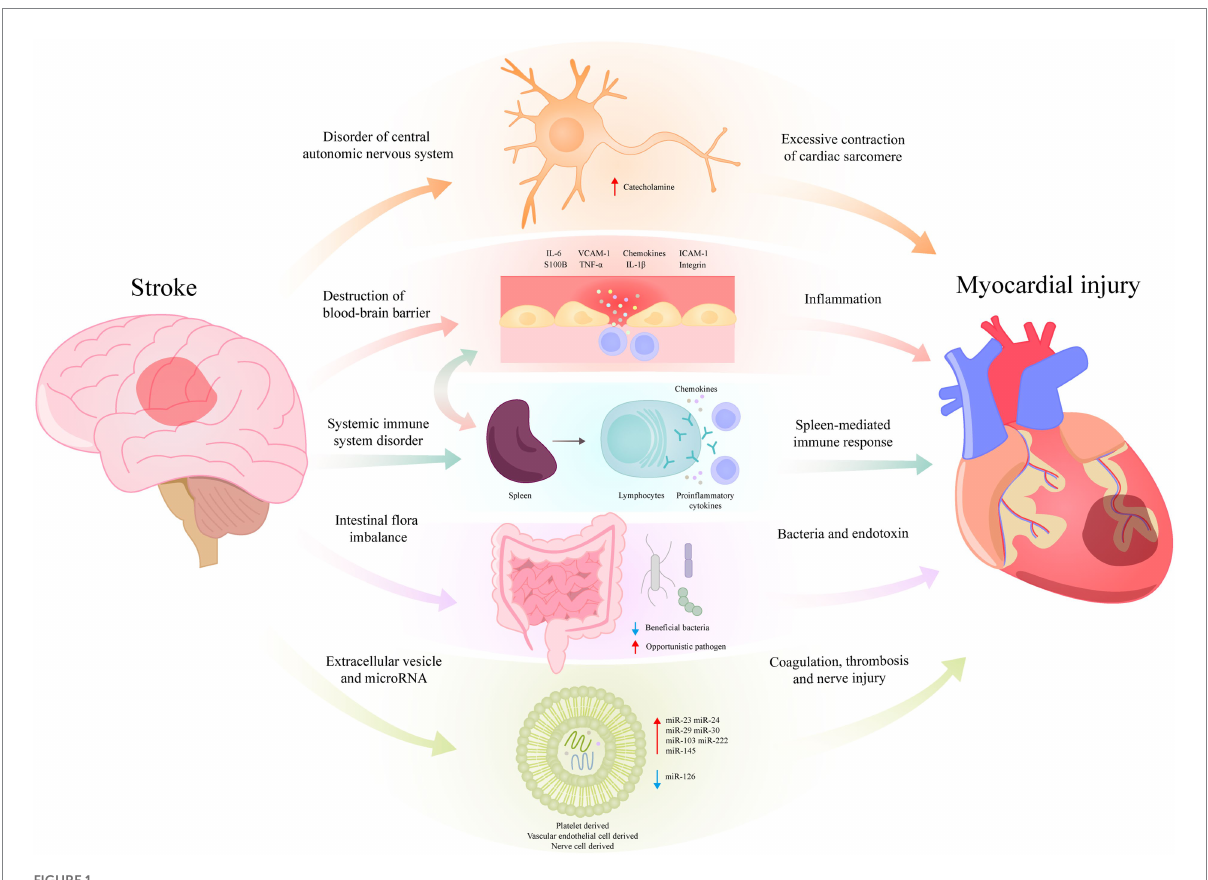
FIGURE 1 Possible molecular mechanisms of stroke-heart